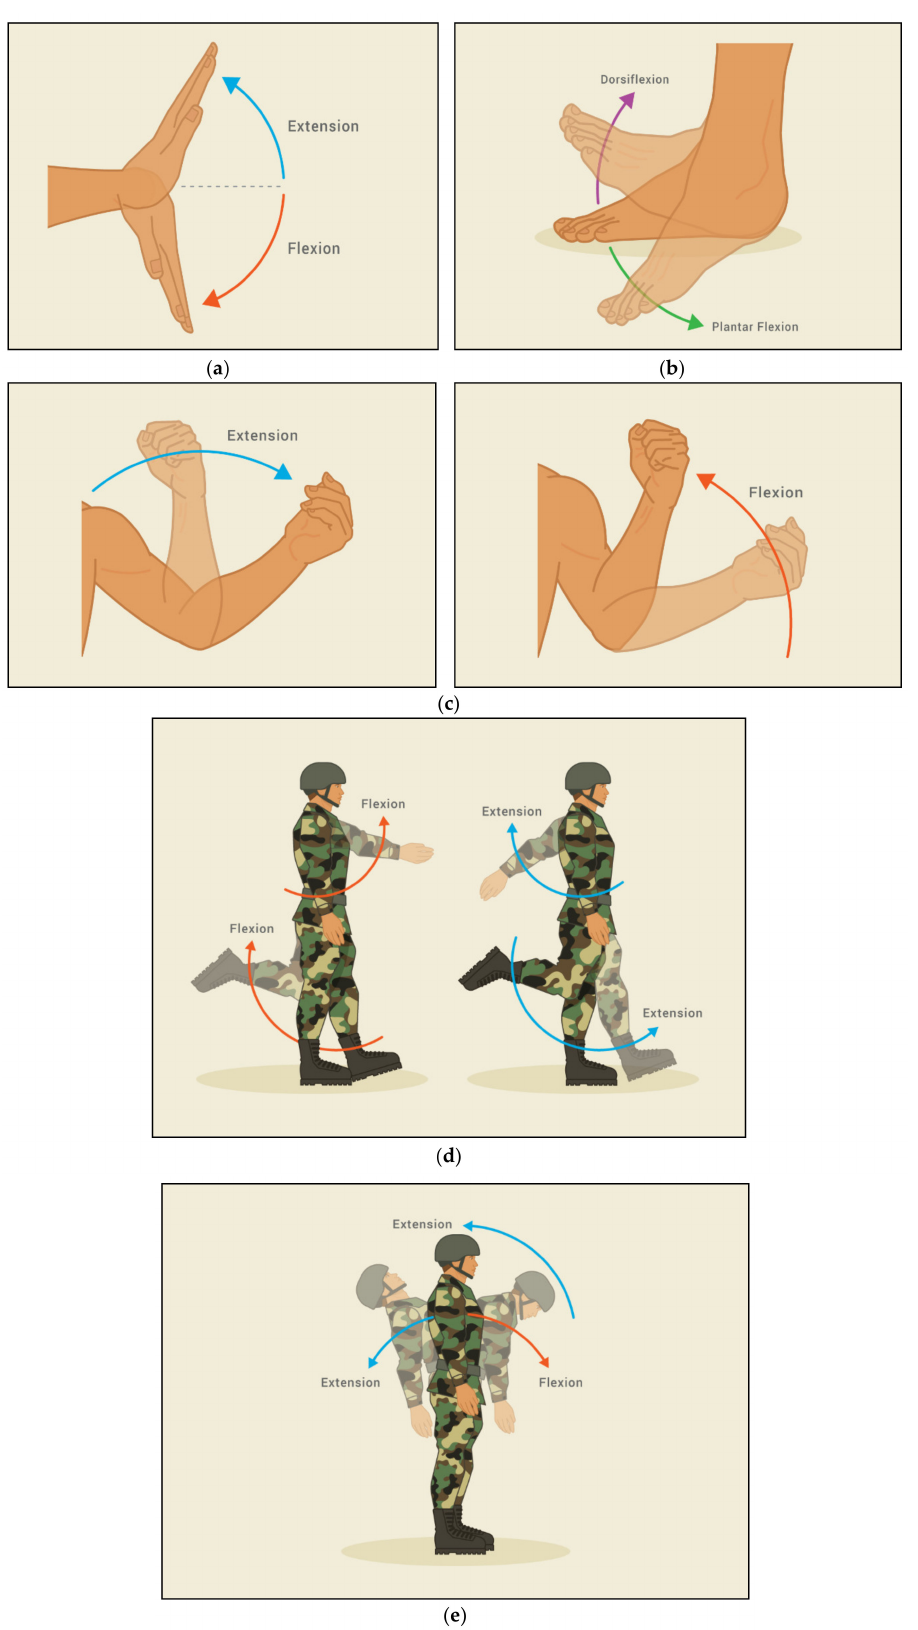
Figure 3. Extension and flexion joint of ( a ) arm, ( b ) ankle, ( c ) elbow, ( d ) shoulder and knee, ( e )